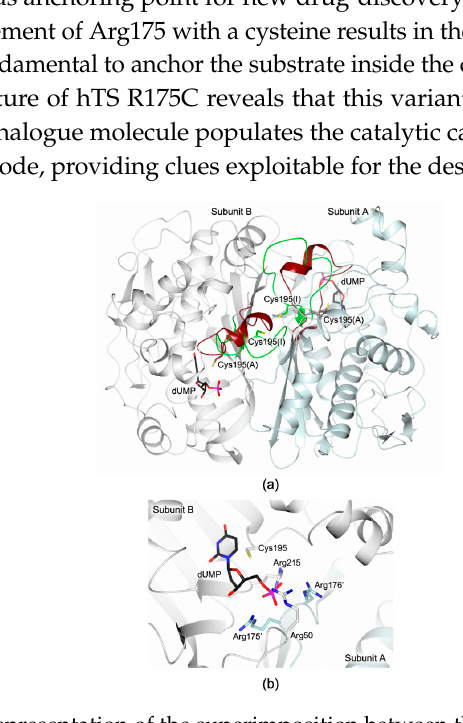
Figure 1. ( a ) Cartoon representation of the superimposition between the hTS homodimer (subunits A and B are coloured light cyan and white, respectively) in the active (PDB id 5X5D [11]) and inactive (PDB id 3N5G [12]) conformations. The two orientations of the catalytic loop (residues 181–197), defining the active (brown trance) and inactive (green trace) conformations, are displayed. The catalytic cysteine is shown in sticks in the active (A) and inactive (I) conformations (brown and green carbons, respectively). The position of the catalytic cavity is indicated by the presence of the substrate 2’-deoxyuridine-5’-monophosphate (dUMP, in sticks, black carbons; PDB id 5X5D [11]). ( b ) Four-arginine cluster anchoring the dUMP phosphate in the hTS active site. The cluster is composed by Arg50, Arg215, Arg175’, and Arg176’ (the last two from the partner subunit). In all figures, nitrogen atoms are coloured blue, oxygen red, sulphur yellow, and phosphorous